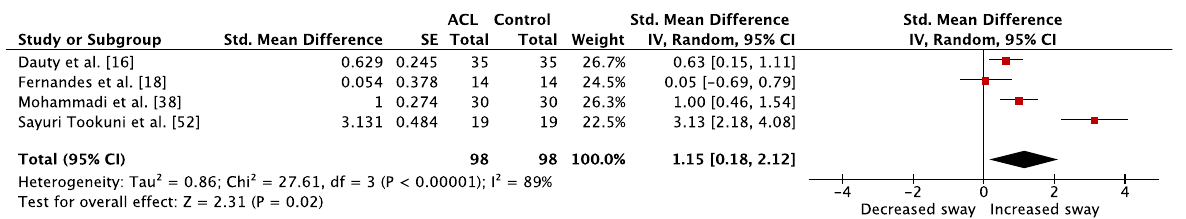
Fig. 4 Forest plot comparison of mediolateral sway magnitude between the ACL-injured and ACL-matched control leg. Std . standardized, SE standard error, IV inverse variance, CI confidence interval, df degrees of freedom, ACL anterior cruciate ligament